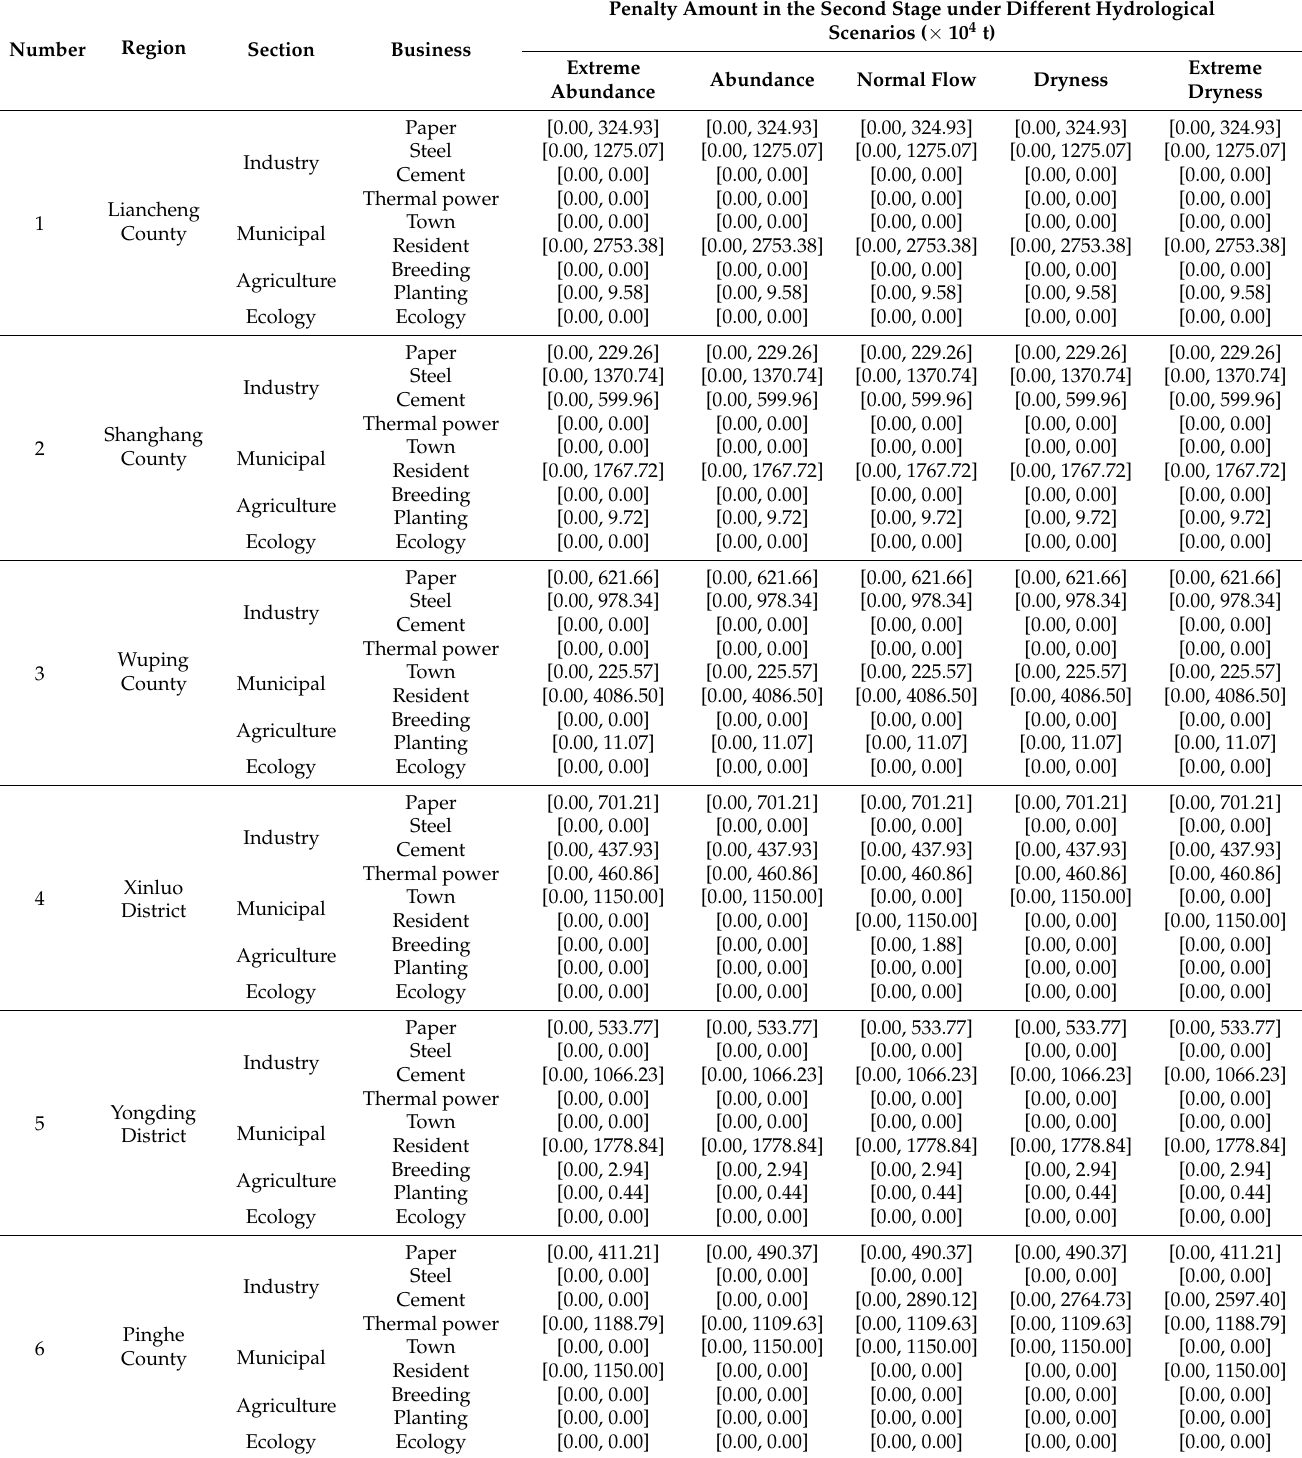
Table 2. Water additional configuration of IFTS model in phase 2 under different hydrological